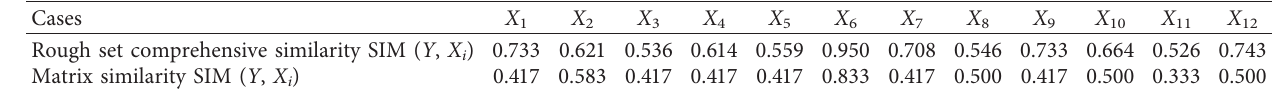
Table 8: Comparative study of rough set case retrieval and matrix case